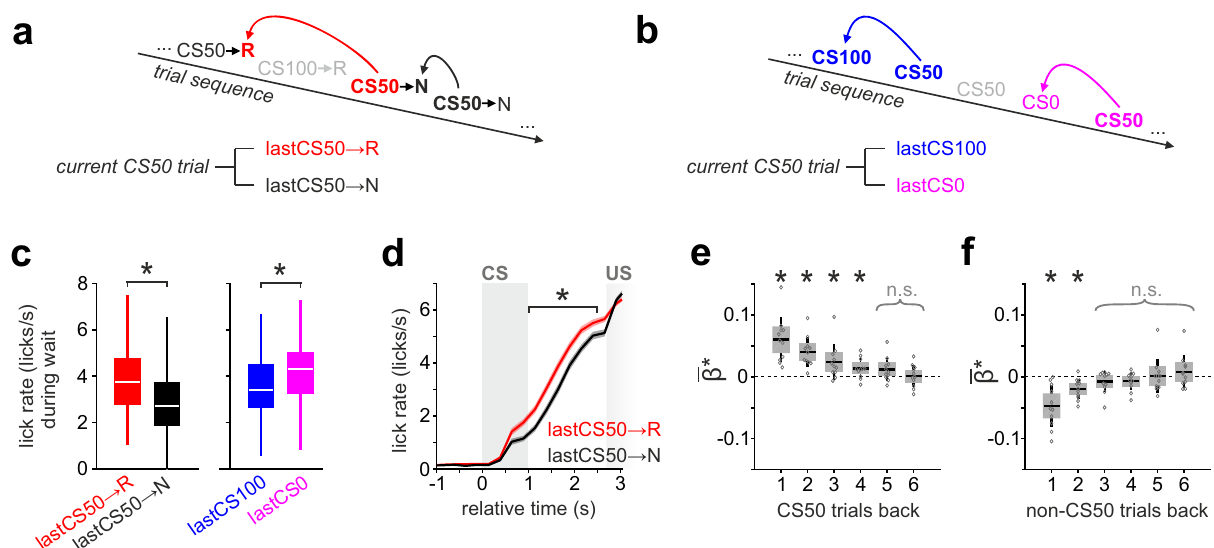
Fig. 9 Updating of reward behavioral anticipation through the recent cue-speci fi c outcome history. a Scheme illustrating the division of CS50 trials based on their recent reward outcomes to test for dependence from “ cue-speci fi c outcome history ” . CS50 trials were grouped according to the outcome of the previous CS50 trial being rewarded (lastCS50 → R) or not (lastCS50 → U). b To assess how the dynamic value updating in CS50 trials is in fl uenced by “ satiety ” , i.e., reward outcomes paired to other stimuli, we separated CS50 trials depending on whether the preceding trial was CS0 or CS100. c Lick rate during wait in CS50 trials was modulated by the outcome of the preceding trial ( n = 88 sessions in 11 animals; two-tailed paired t test). Note that receiving a reward has a differential effect on the lick rate during the next trial depending on the stimulus identity. d Licking intensities differentiated CS50 trials throughout the waiting interval depending on the outcome of the previous CS50 trial (two-tailed paired t test). Displayed average lick rates ± SEM. e Multiple Poisson regression with anticipatory licks in CS50 trials (during delay window) as a dependent variable and the outcome of the six previous CS50 trials as independent variables (one-sample t test on the resulting beta, n = 88 sessions in 11 animals). Anticipatory licking in CS50 trials was positively modulated by the outcome of the last four CS50 trials. f Same as ( e ) but with the outcome of the six previous CS100 and CS0 trials as independent variables. Anticipatory licks in CS50 trials were negatively modulated by the outcome of the prior non-CS50 trials. In the fi gure, * indicates P < 0.05 (see Supplementary Table 1 for exact P values and test details). Box plots: The bounds of the box represent 25th to 75th percentiles. The center indicates the median. The lower and upper whiskers represent the minimum and maximum values without outliers; outliers indicated by circles. Source data are provided as a Source Data fi